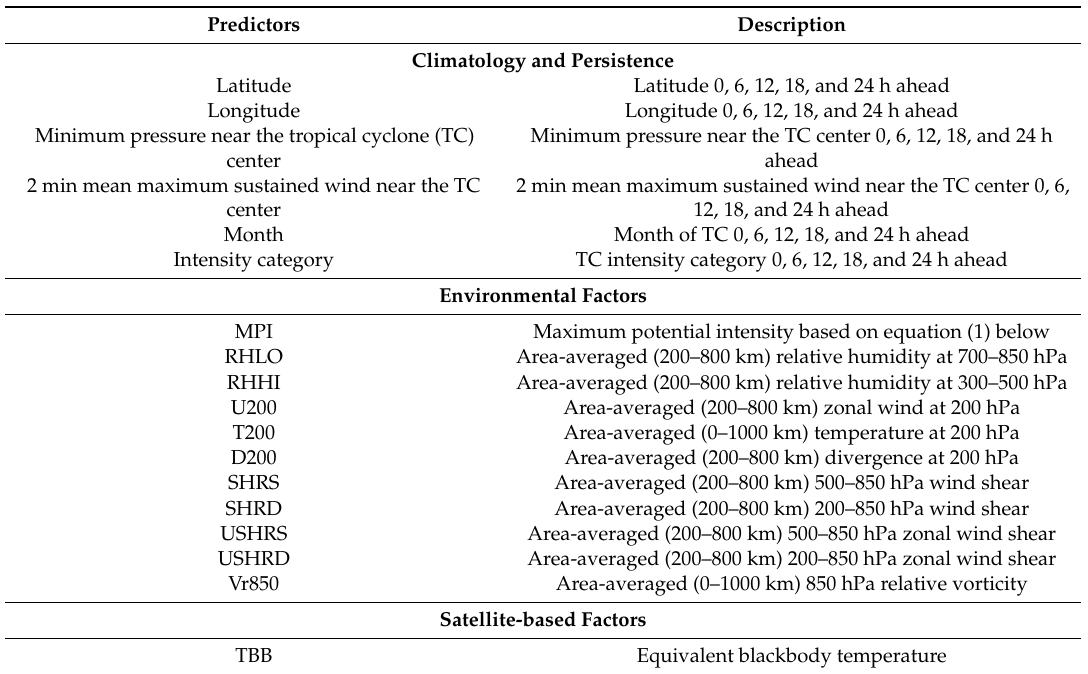
Table 3. Climatology and persistence, environmental, and satellite-based predictors used in this